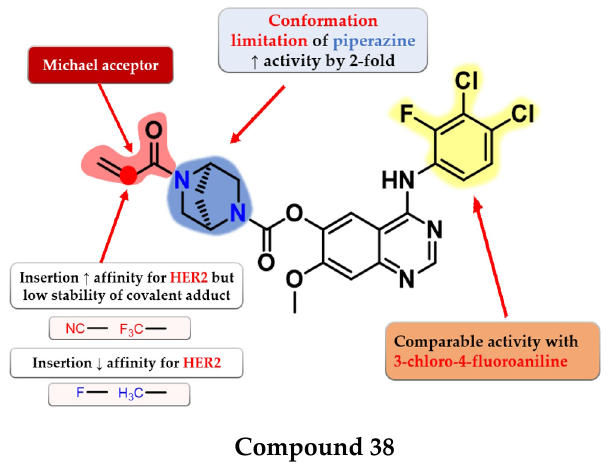
Figure 25. Structure–activity relationship of compound 38 , as reported by Jiao et al. [182].